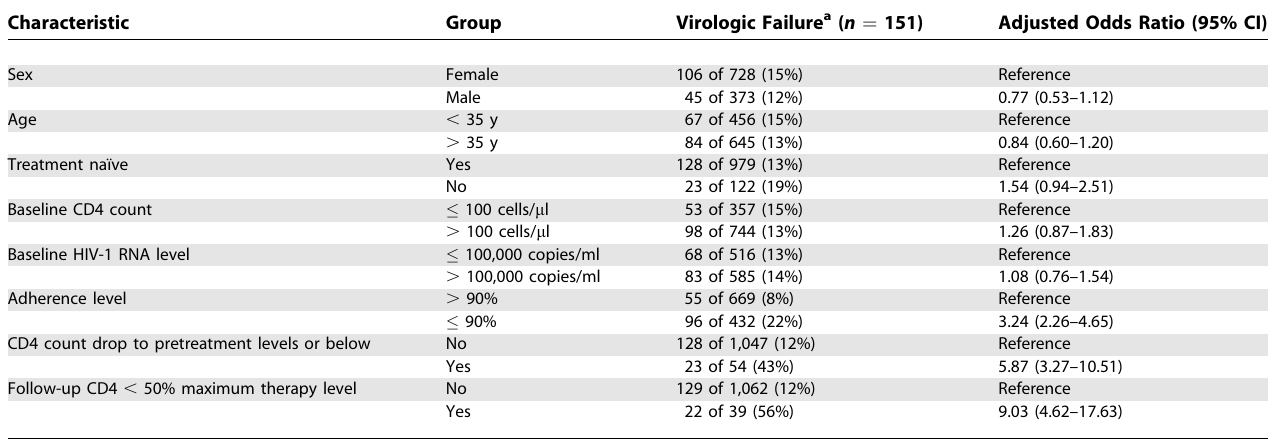
Table 4. Characteristics of Patients with and without Breakthrough Viremia after Initial Virologic Suppression on NNRTI-Based cART ( n ¼ 1,101) Characteristic